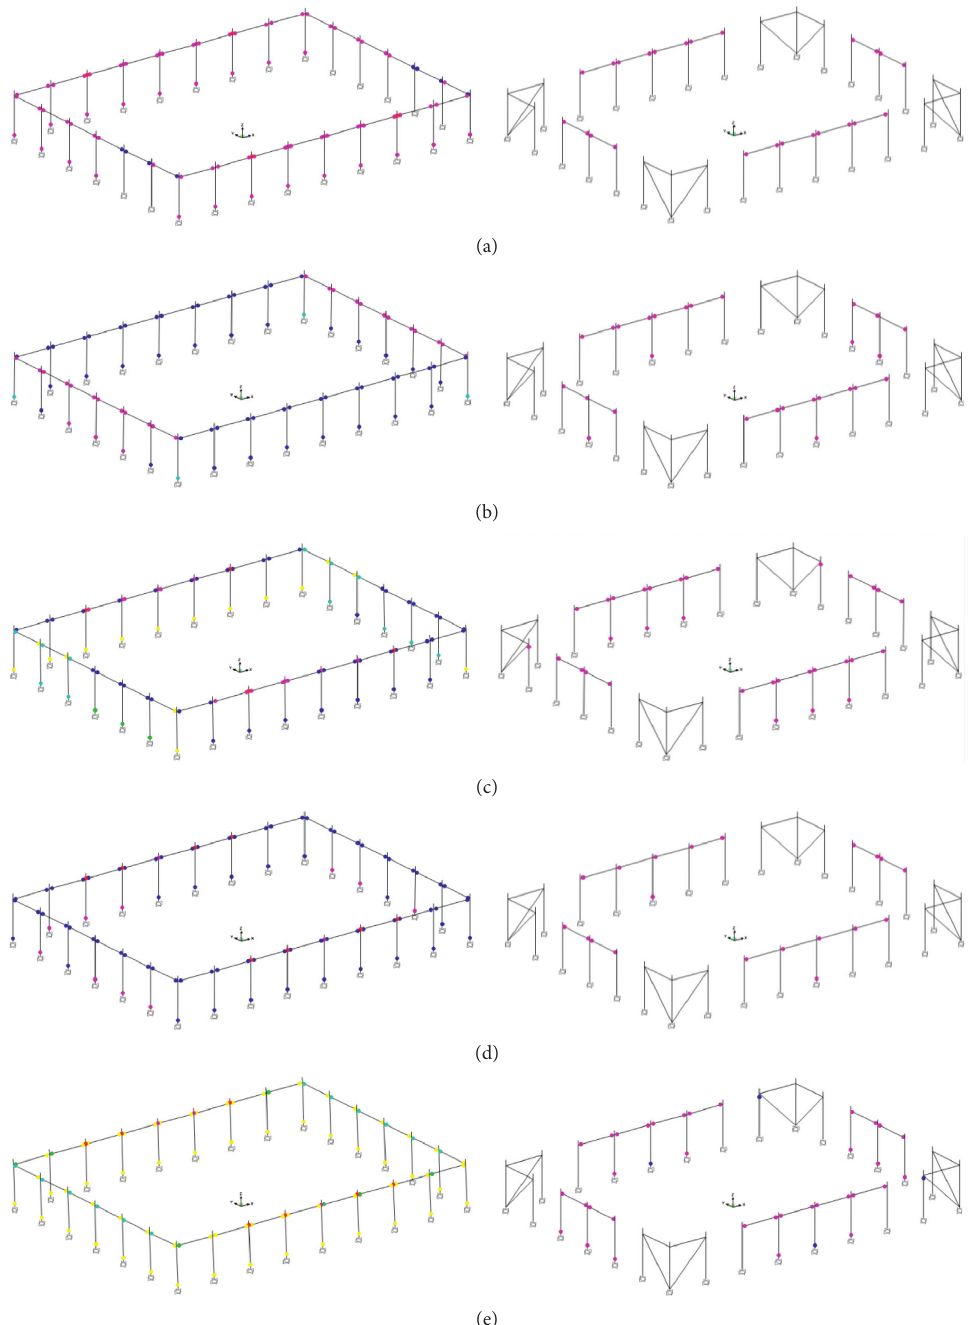
Figure 20: Plastic hinges under different earthquakes (left: SS-RC; right: SS-SRC). (a) Tohoku, (b) Mammoth Lakes, (c) Chi-Chi, (d) El Centro, and (e)